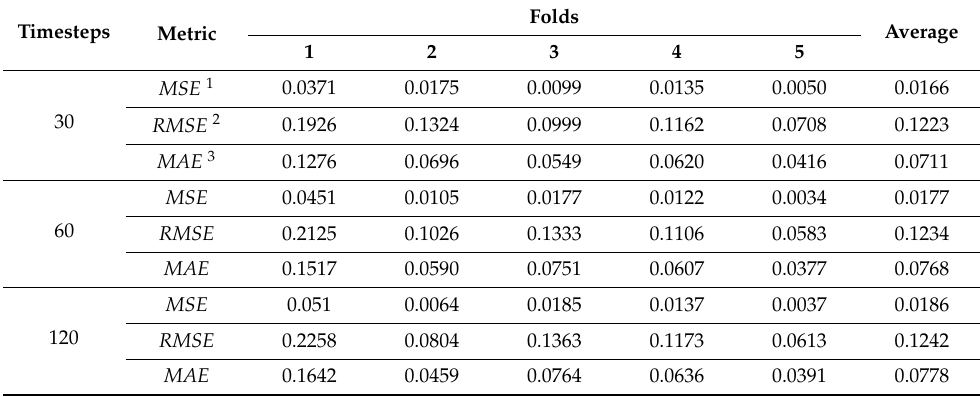
Figure 7. COVID-19 recession period prediction using LSTM for ( a ) 30 timesteps, ( b ) 60 timesteps, and ( c ) 120 timesteps. Shaded area represents standard deviation. Table 4. Performance metrics for each timesteps during the COVID-19 recession.